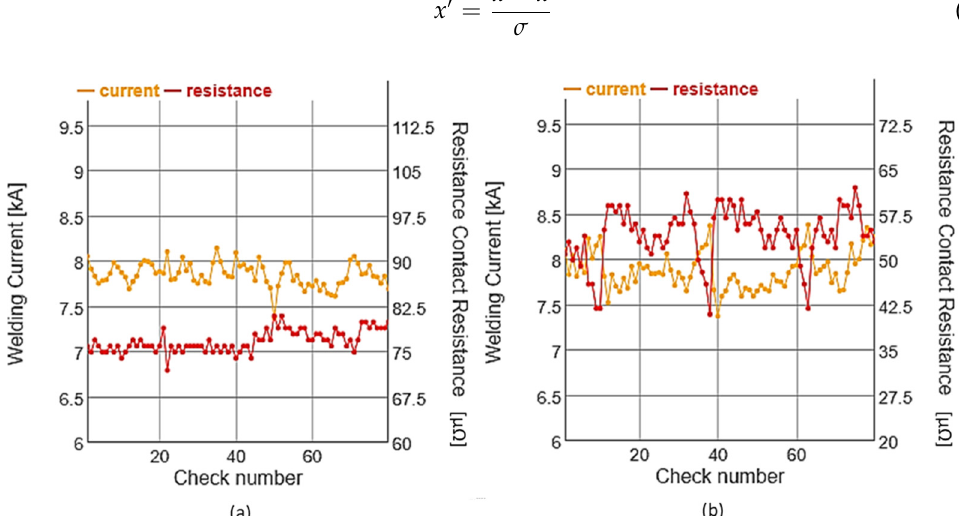
Figure 6. Example of current and resistance data acquired for a weld control. ( a ) Example of the data